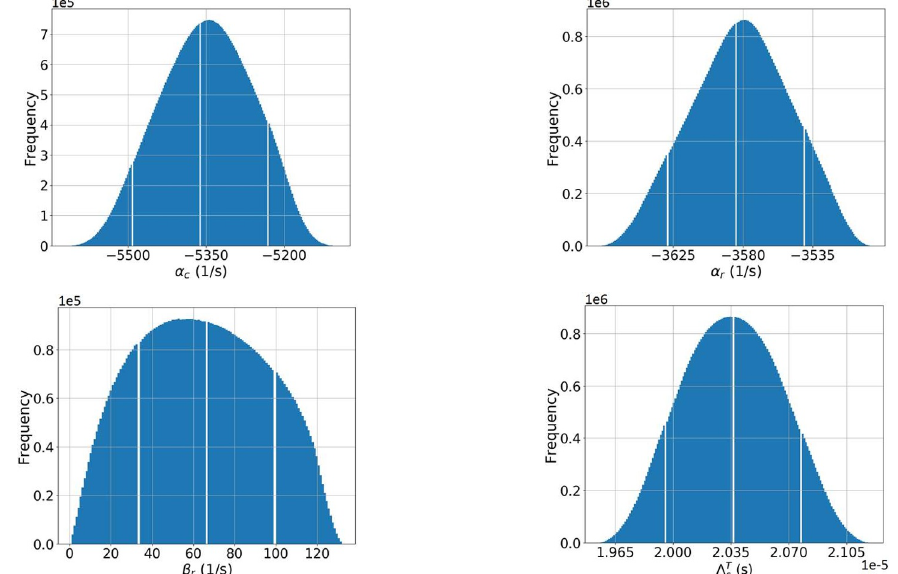
Figure 4. Frequency of Occurrence of Acceptable Values for 𝜶